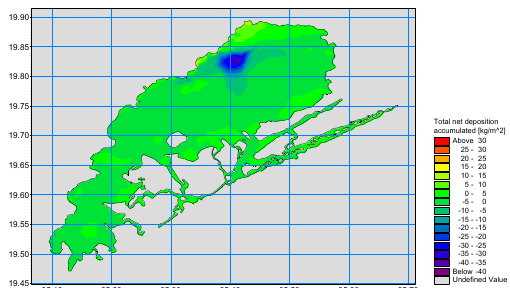
Figure 7j. Simulated spatial profile of Total net deposition accumulated-fraction 1 (kg/m 2 ) (kg/m 3 ), Bed thickness-layer 1 (m), Bed thickness-layer 1 (m), Total Suspended Sediment concentration (kg/m 3 ), settling velocity - layer 1 (m/s), Total bed thickness change (m), Total bed mass thickness change (kg/m 2 ), Erosion -fraction 1 (kg/m 2 /s), Net deposition -fraction 1 (kg/m 2 /s) and Total net deposition accumulated-fraction 1 (kg/m 2 ) are shown in Figure 7a to